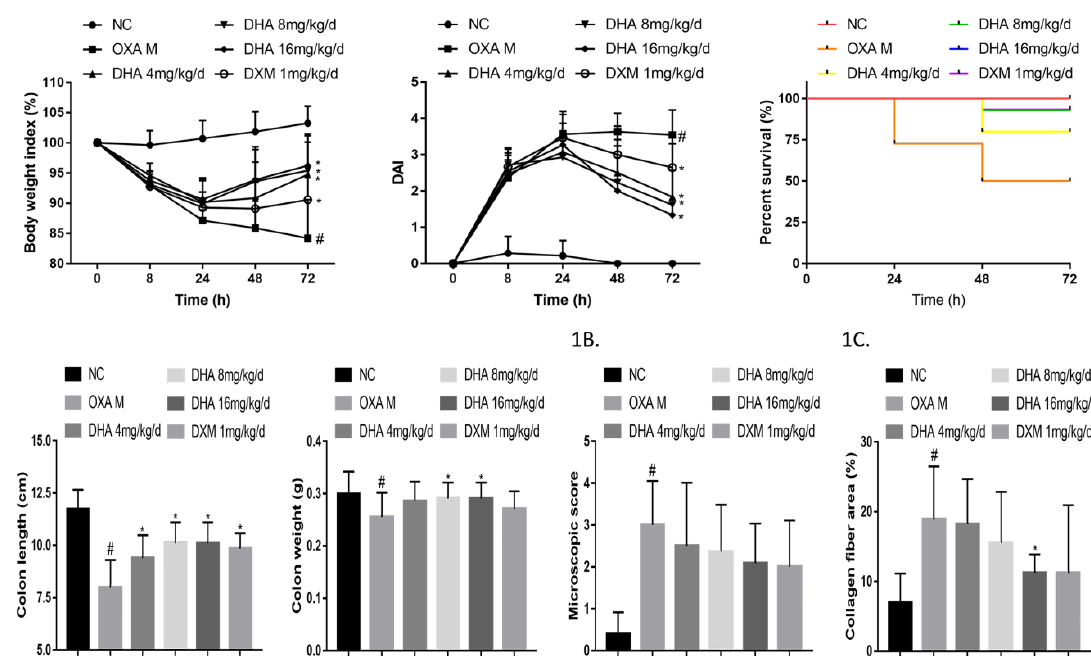
Figure 1. Dihydroartemisinin (DHA) ameliorates oxazolone (OXA)-induced colitis in a